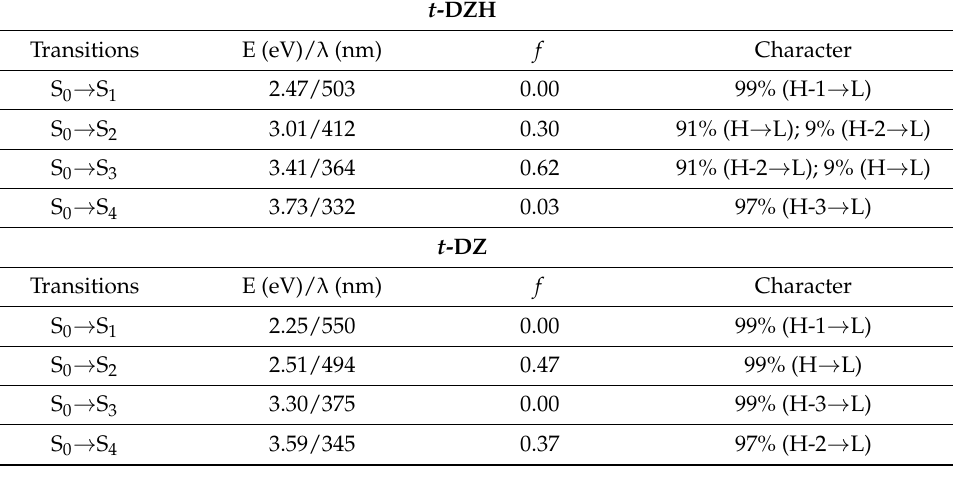
Table 1. Energies, wavelengths, oscillator strengths ( f ), and characters in terms of molecular orbitals of the lowest electronic transitions for t -DZH and t -DZ (H and L stand for HOMO and LUMO). The simulated absorption spectra are reported in Figure S4 of the Supplementary Materials. t -DZH Transitions